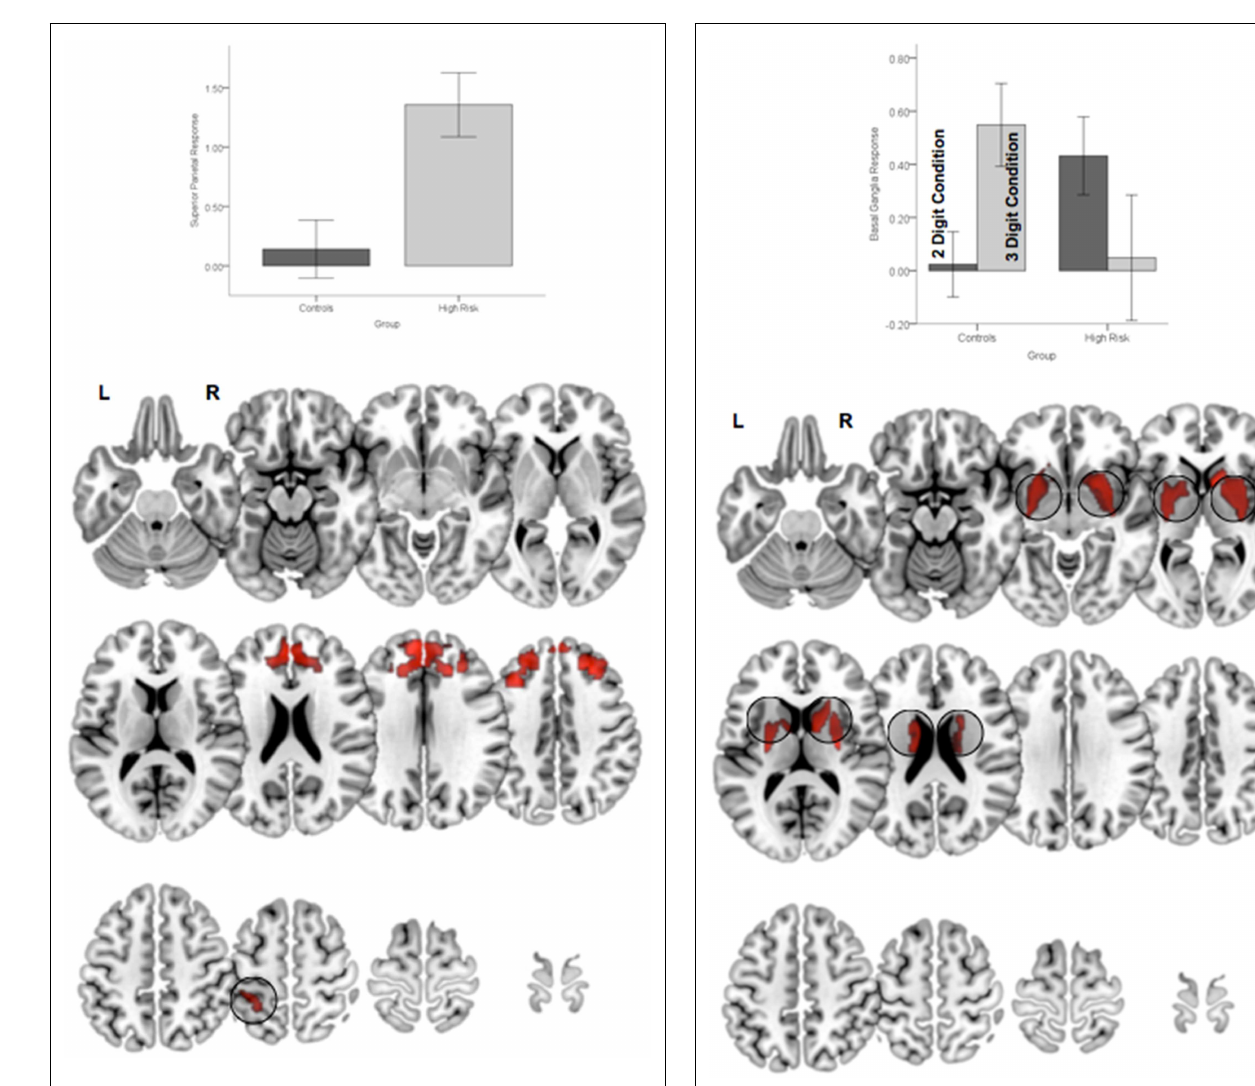
FIGURE 6 | Significant clusters ( p < 0.05, cluster level) under the group × attention demand interaction term are rendered on an ascending mosaic of axial views . As seen in the graph, the interaction was driven by increased engagement with demand in controls, but decreased engagement in high-risk subjects. By implication, the BG, a core region in the executive attention circuit, appears to “turn off” in risk subjects with an increase in attention-related